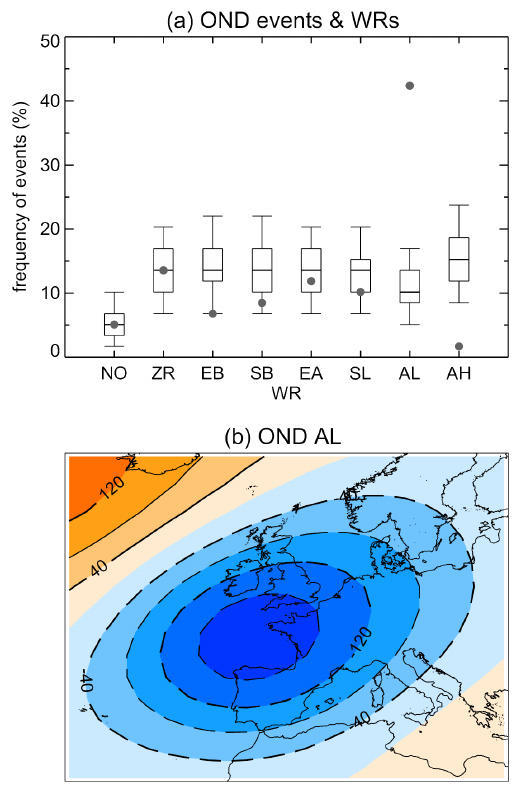
Figure 8. (a) Relative frequency of autumn extreme daily mean de- trended water heights above the 99.5th percentile of the 1948–2018 (in per cent with respect to the total number of events) occurring under the given weather regime (WR). Whiskers denote the random distributions obtained from a bootstrap of 5000 trials, each one con- taining the same number of autumn days of the 1948–2018 period as surge events. Boxes denote the inter-quartile distribution, with the median in between, and bars extend from the 5th to the 95th percentile of the random distributions. WRs are defined from daily fields of geopotential height at 500hPa of the NCEP/NCAR reanal- ysis over the Euro-Atlantic sector [30, 65] ◦ N, [30 ◦ W, 25 ◦ E]. Ab- breviations are as follows: NO – no (i.e. undefined) WR, ZR – zonal regime, EB – European blocking, SB – Scandinavian blocking, EA – East Atlantic, SL – Scandinavian low, AL – Atlantic low, AH – Atlantic high. See Garrido-Pérez et al. (2020) for further details. (b) The AL pattern that is associated with the occurrence of more than 40% of extremes. Data sources: NCEP/NCAR reanalysis (Kalnay et al.,